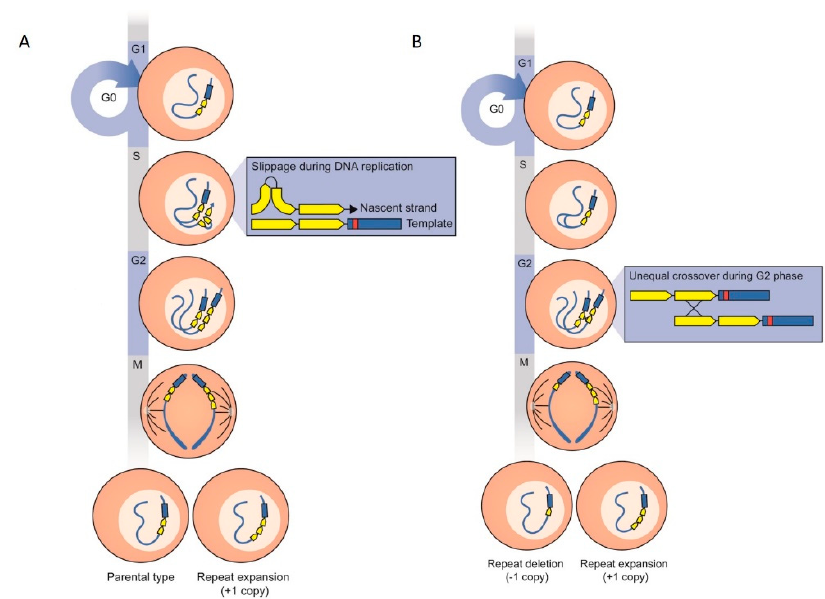
Figure 6. Possible mechanisms of extension from two to three 34 bp tandem repeats (TRs) in the promoter region of the cyp51A gene during the mitotic cell cycle. ( A ) Replication slippage: when strand slippage occurs during DNA replication in the S-phase of the mitotic cell cycle, a DNA strand with the repeat may loop out resulting in addition of the repeat number [15]. ( B ) Unequal sister chromatid recombination: during the S / G2 phase, unequal crossing over may occur between the repeats of the sister chromatids resulting in an extra copy of the repeat on one chromatid.